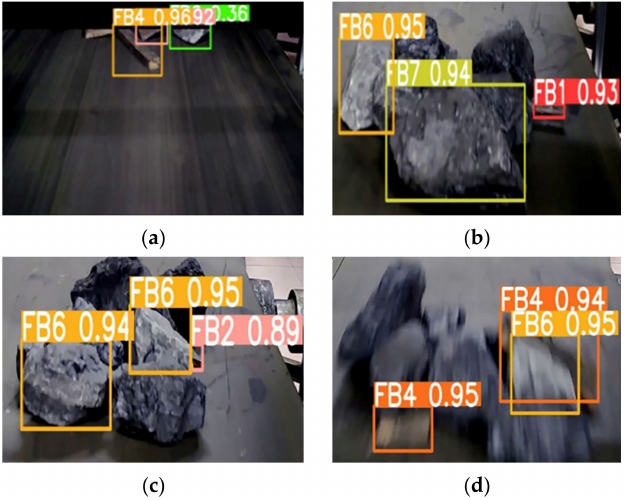
Figure 10. Test results of laboratory. ( a ) Recognition results of FB2, FB4 and FB6 in the laboratory. ( b ) Recognition results of FB1, FB6 and FB7 in the laboratory. ( c ) Recognition results of FB2 and FB6 in the laboratory. ( d ) Recognition results of FB4 and FB6 in the